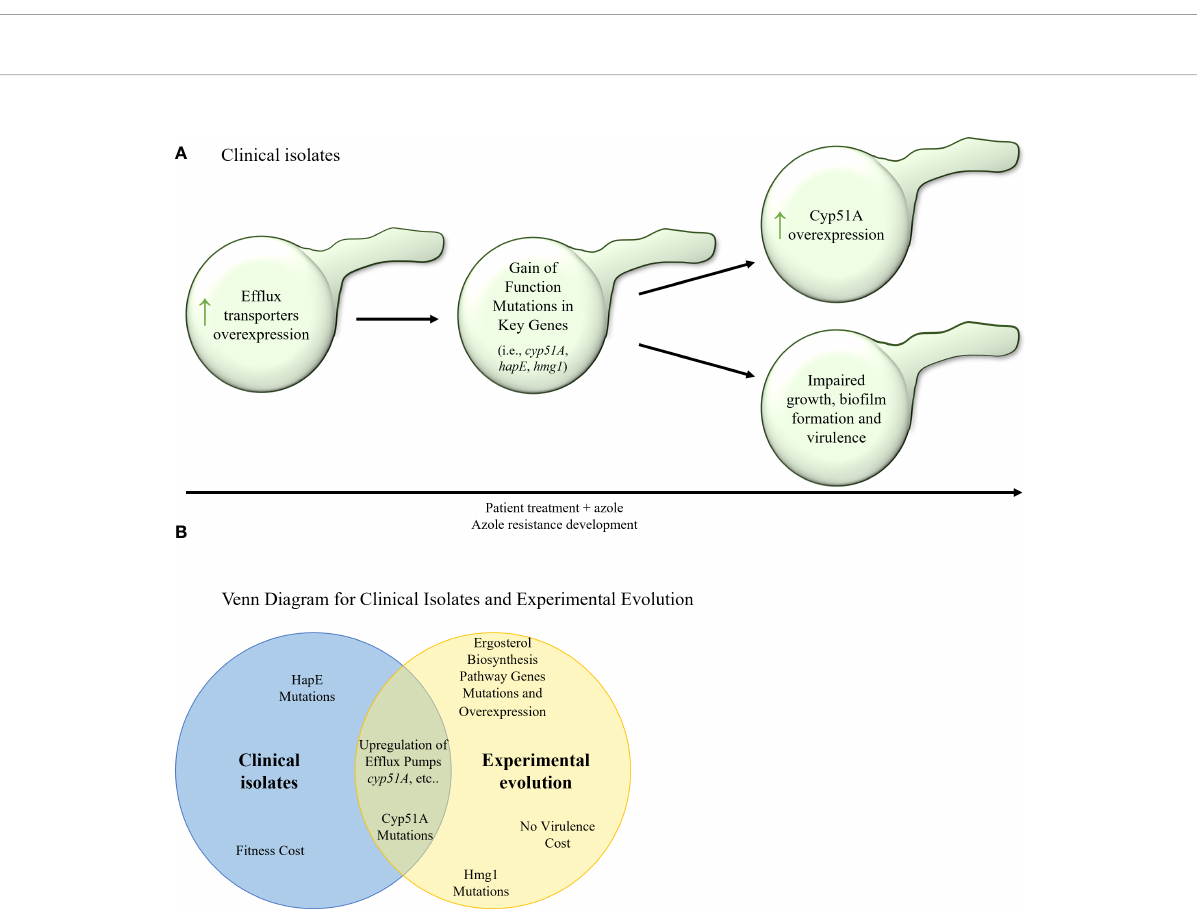
FIGURE 4 (A) Stepwise evolution of triazole resistance acquisition in serial clinical isolates of A. fumigatus . An increase of ef fl ux transporter activity is followed by gain – of – function mutations in key genes ( cyp51A , hapE , hmg1 ) and overexpression of key genes (such as cyp51A and other